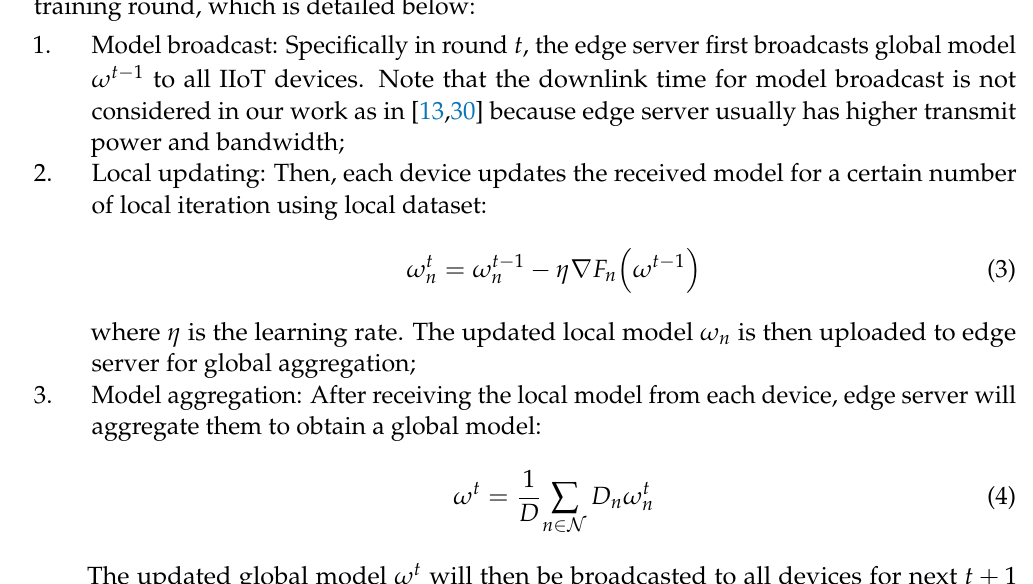
Figure 1. An illusion of system model and proposed edge-assisted FL framework. The IIoT devices and edge server cooperatively update the global model in each FL training round, which is detailed